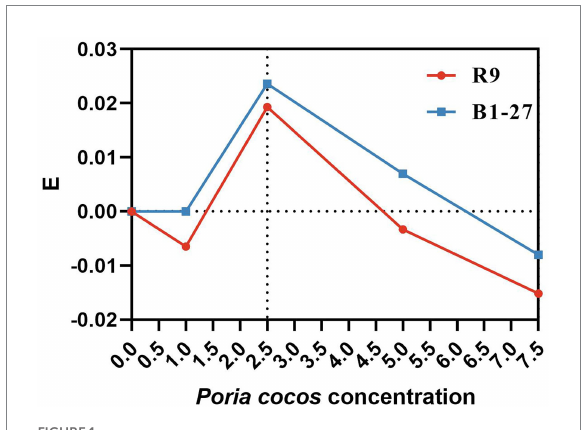
FIGURE 1 E-values of Lactobacillus plantarum R9 and Lactobacillus gasseri B1-27 in Poria cocos fermentation broth at different